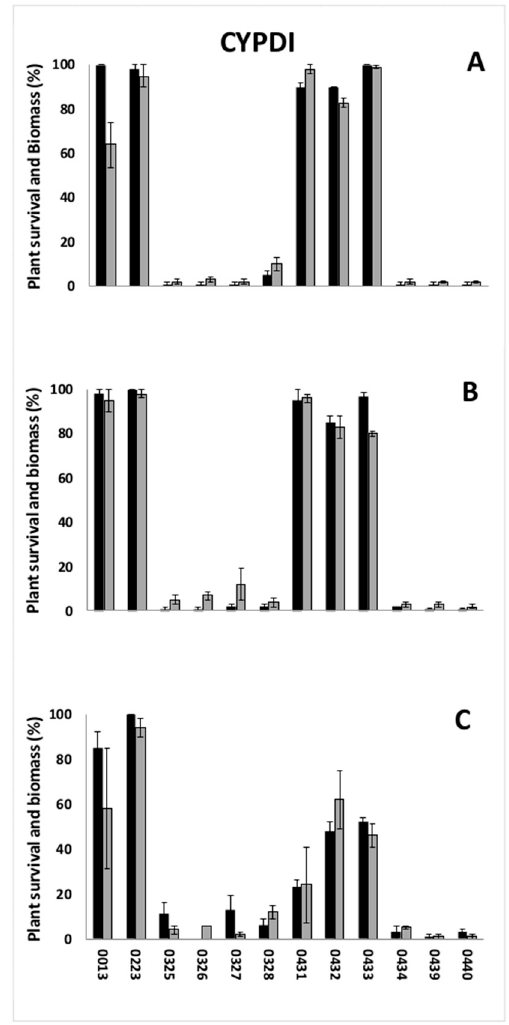
Figure 2. Sensitivity of populations of Cyperus difformis (CYPDI) to three ALS inhibitors, azimsulfuron ( A ), bensulfuron-methyl ( B ), applied at full label dose corresponding to 20 and 60 g ai ha − 1 , respectively, and penoxsulam ( C ), applied at half the full label dose, corresponding to 20 g ai ha − 1 . Populations 0013 and 0223 are ALS-resistant checks. Values of survival (black bars) and biomass (grey bars) are expressed as percentage of the untreated control. Vertical bars represent standard errors.